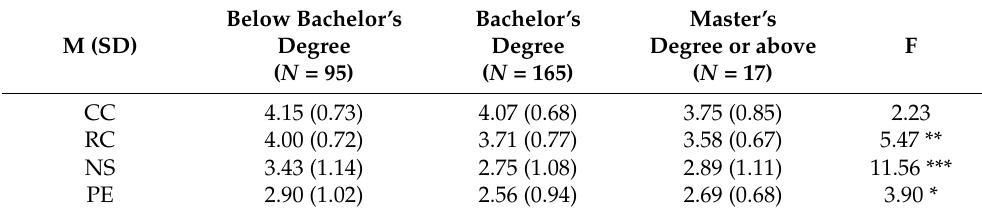
Table 13. Table of standardized path analysis data Path CC RC PEofU → Take-over